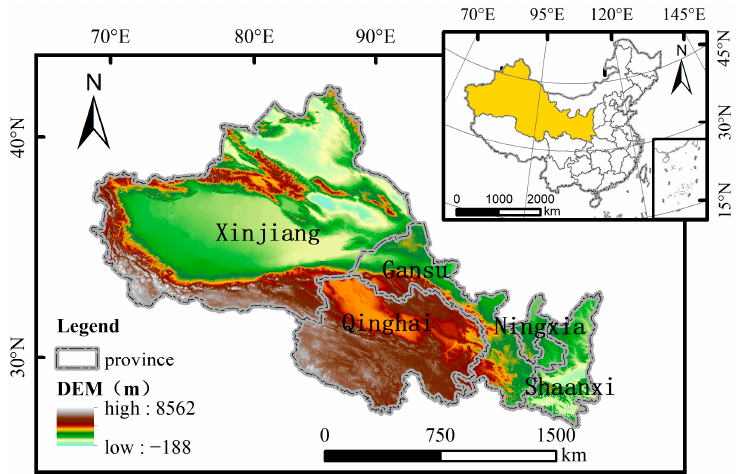
Figure 1. Topographic maps of the study area.